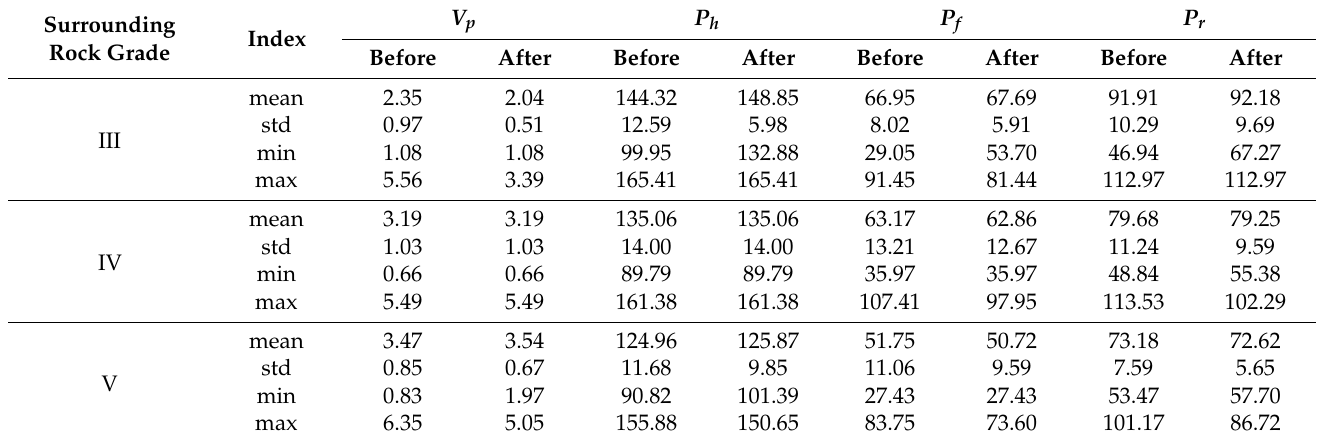
Table 4. Comparison of the data characteristics before and after